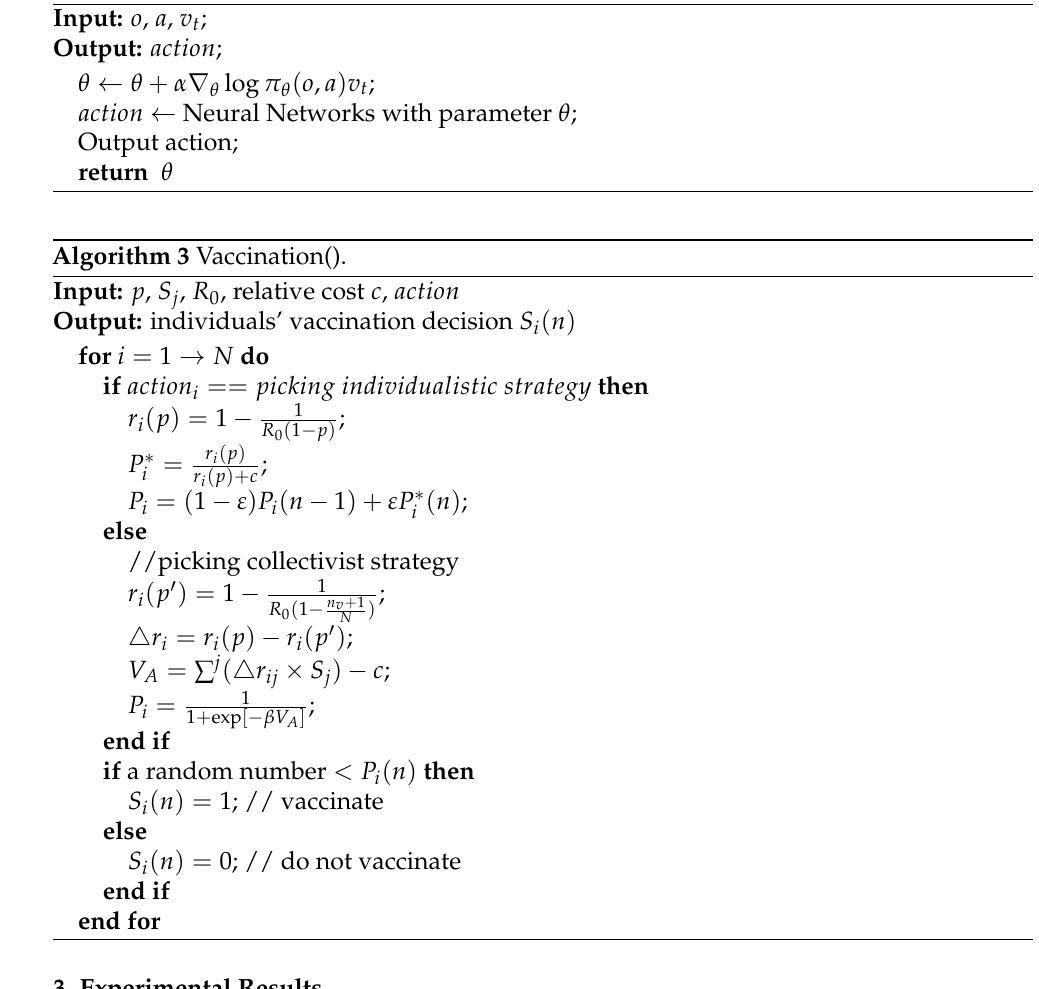
Algorithm 2 Reinforcement learning().